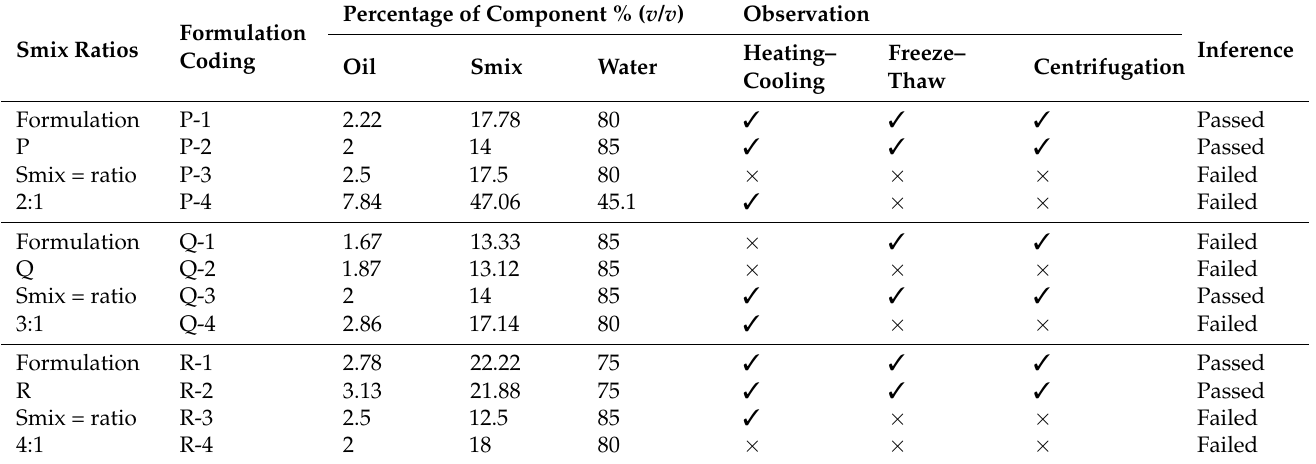
Table 6. Physical characterization studies of various nanoemulsion formulations. Formulation Coding